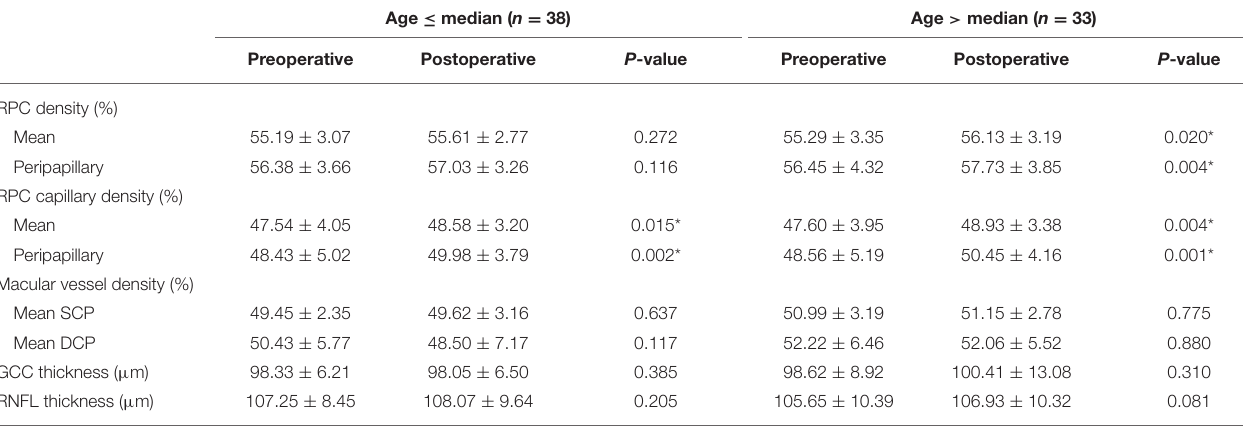
TABLE 5 | Comparison of retinal vessel density before and after surgery in CHD patients of different age groups ( n =